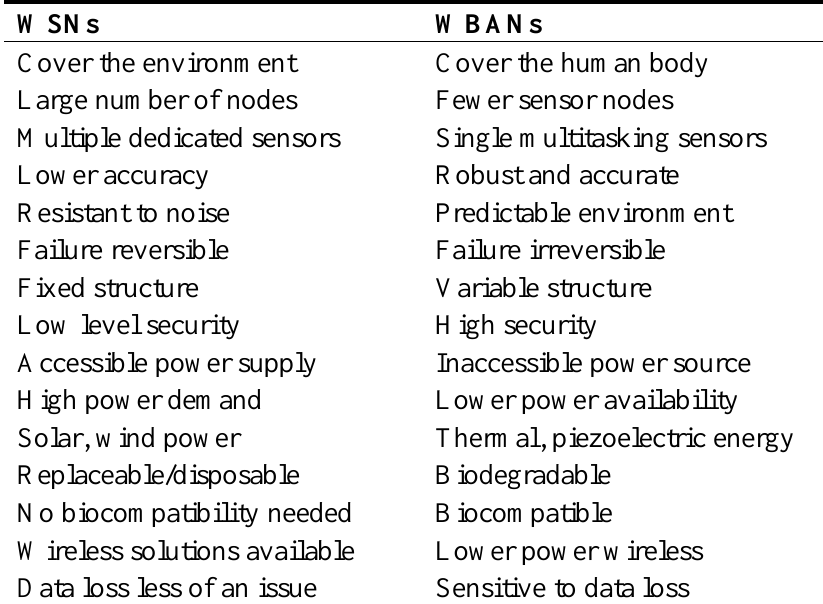
Table 2. Difference between WSNs and